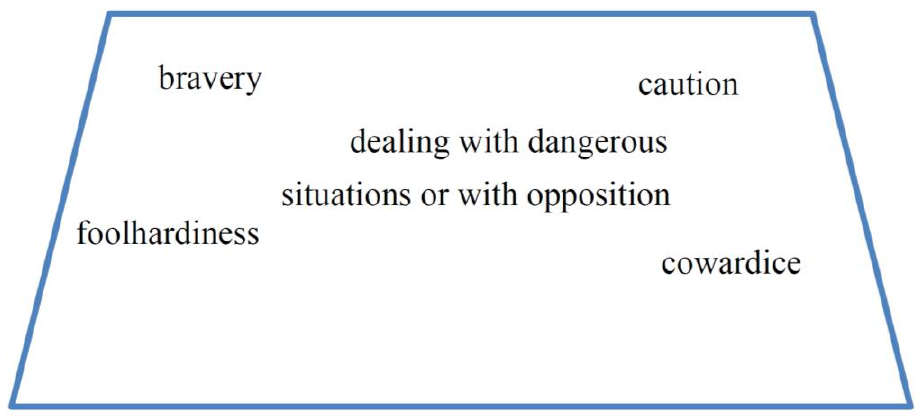
Figure 1. Bravery and Caution Virtuous Trapezium (See Selling 2016, p. 234).